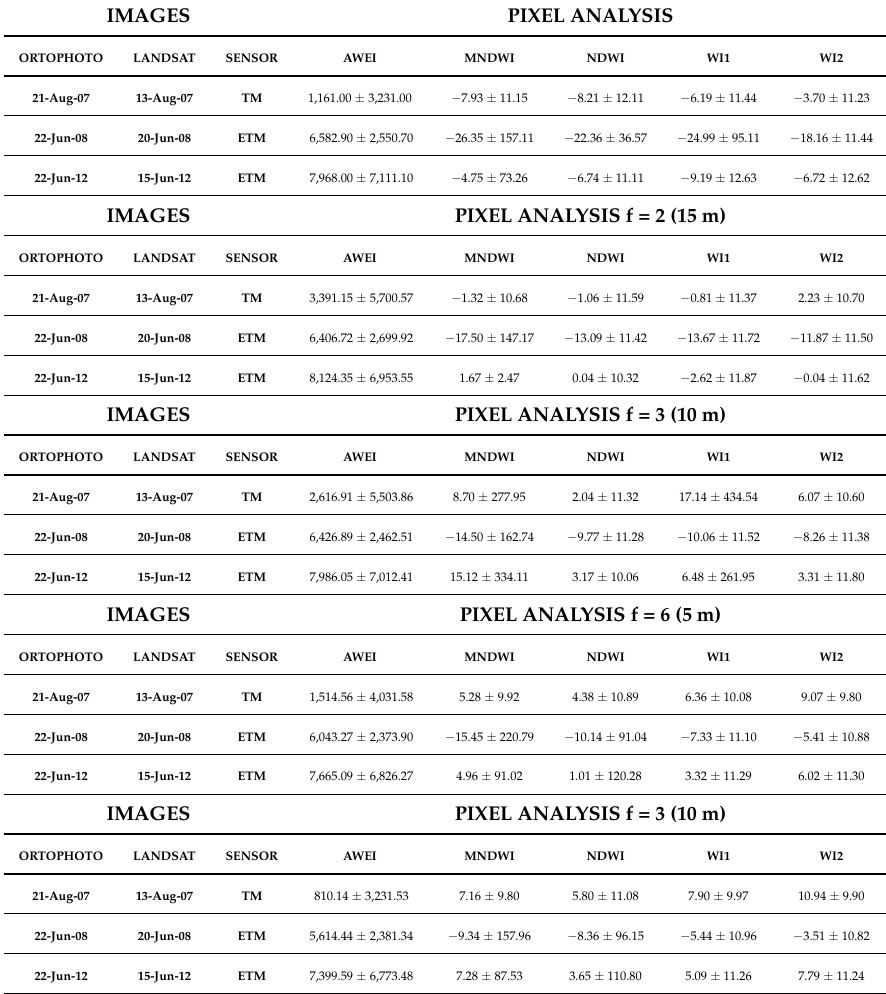
Table A6. Bias comparison (mean ± standard deviation) between Landsat images analyzed and high-resolution ortophotos at the pixel level in the Ebro River Delta. IMAGES PIXEL ANALYSIS ORTOPHOTO